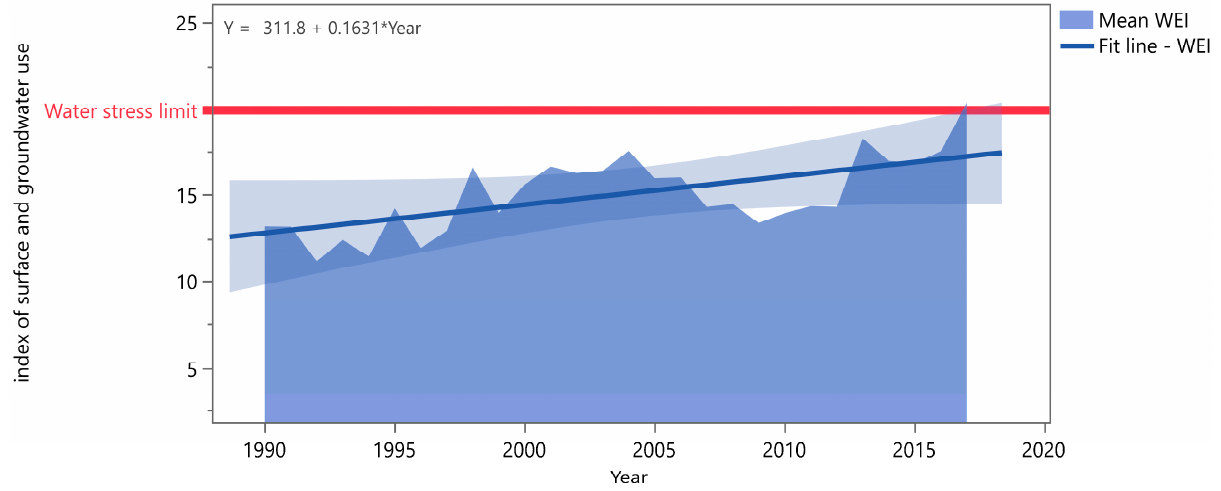
Figure 1. Index of water use (%) in 1990–2017–EU average.